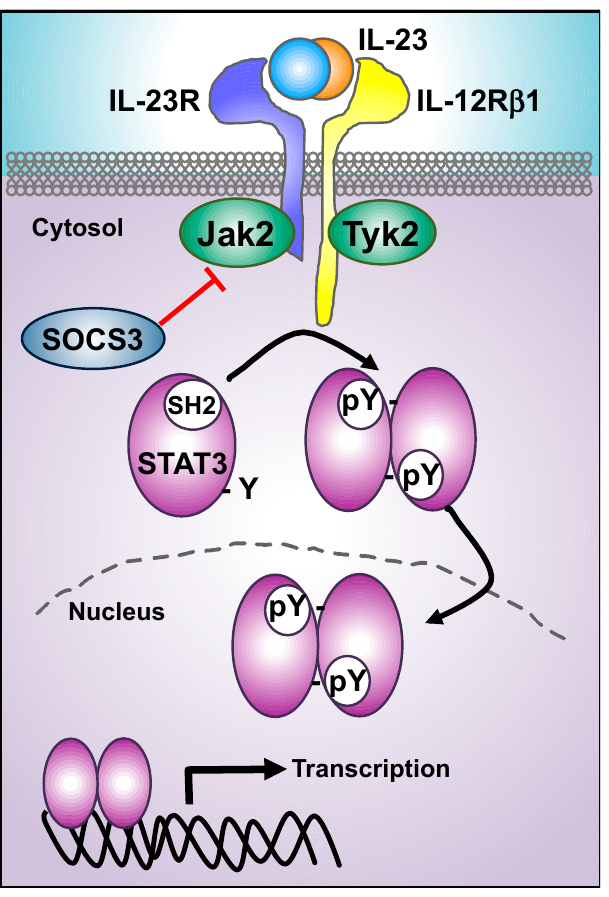
Figure 2. IL-23 proximal signaling cascade: Janus tyrosine kinases (JAKs)/signal transducer and activator of transcription (STATs) module. IL-23 receptor complex is associated with the JAK family members Jak2 and Tyk2. IL-23 binding to the IL-23R promotes JAKs activation and phosphorylation of Tyr residues (pY) in both the JAKs themselves and in the IL-23R cytoplasmic tail, creating docking sites for STAT3 monomers through Src homology 2 domains (SH2). Active Jak2/Tyk2 phosphorylate STAT3 monomers, leading to dimerization, nuclear translocation, and DNA binding to target gene promoters.